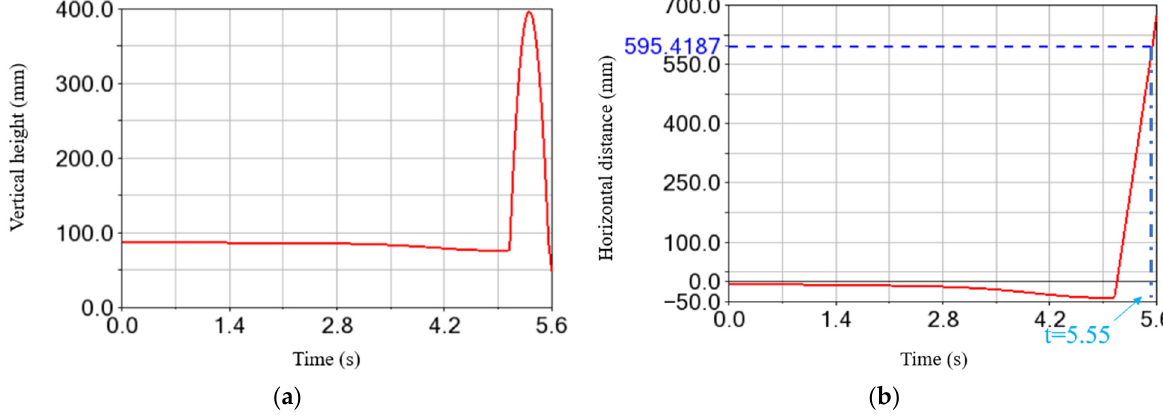
Figure 10. ( a ) Vertical height displacement of the center of mass; ( b ) Horizontal distance displacement of the center of mass.